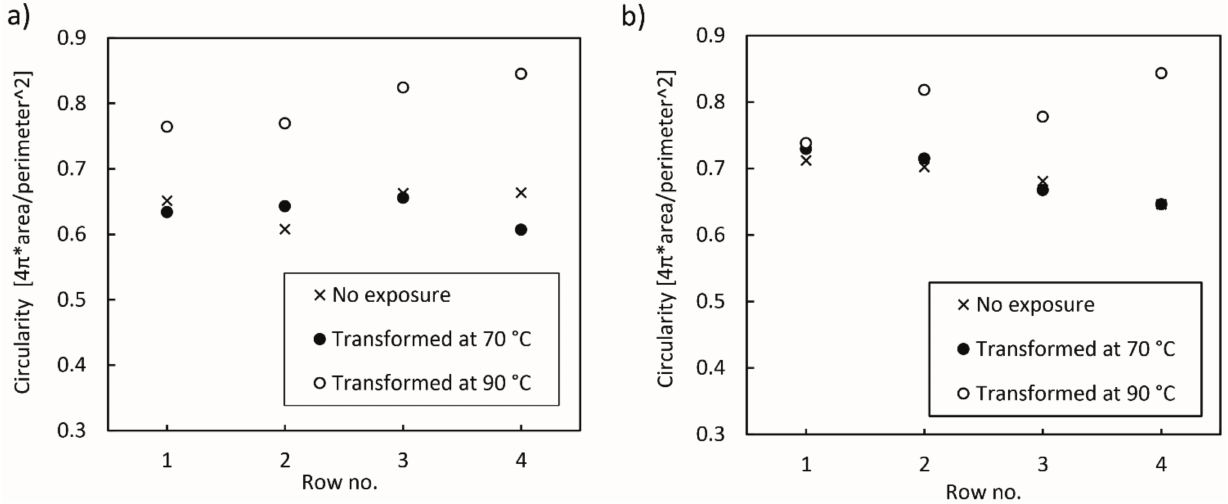
Figure 15. Circularity of voids in rows between layers determined on 3D printed test samples: ( a ) optimised printing conditions, ( b ) non-optimised printing